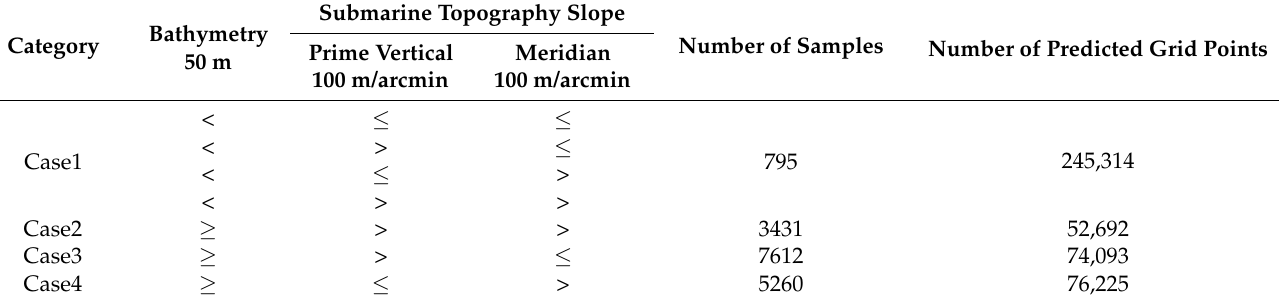
Table 5. Classification.